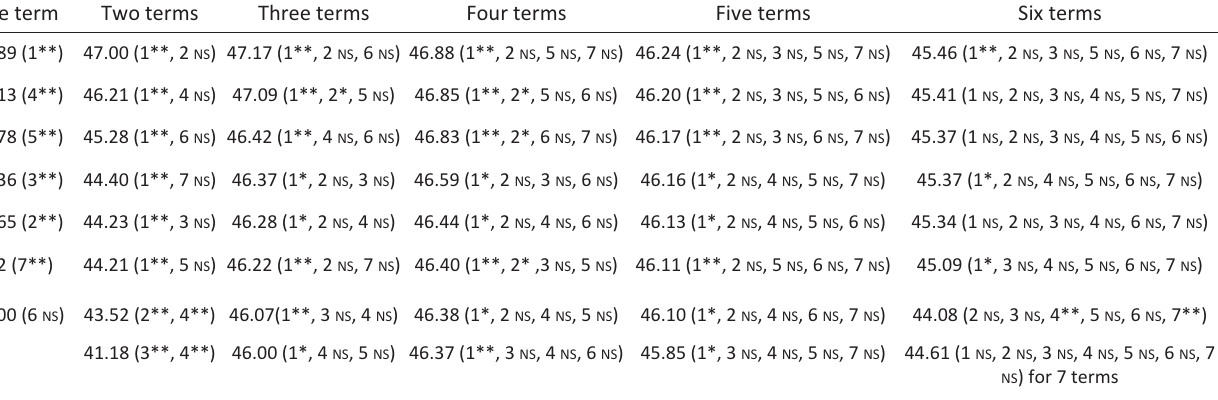
Table 4 ­ Adjusted R2 of subsets linear regression of morphological and yield parameters against growth habit of tomato cultivars across rates of fertilizer